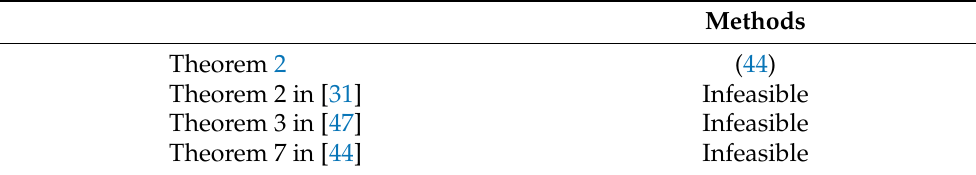
Table 1. Comparison of the feasibility results by different methods for γ =